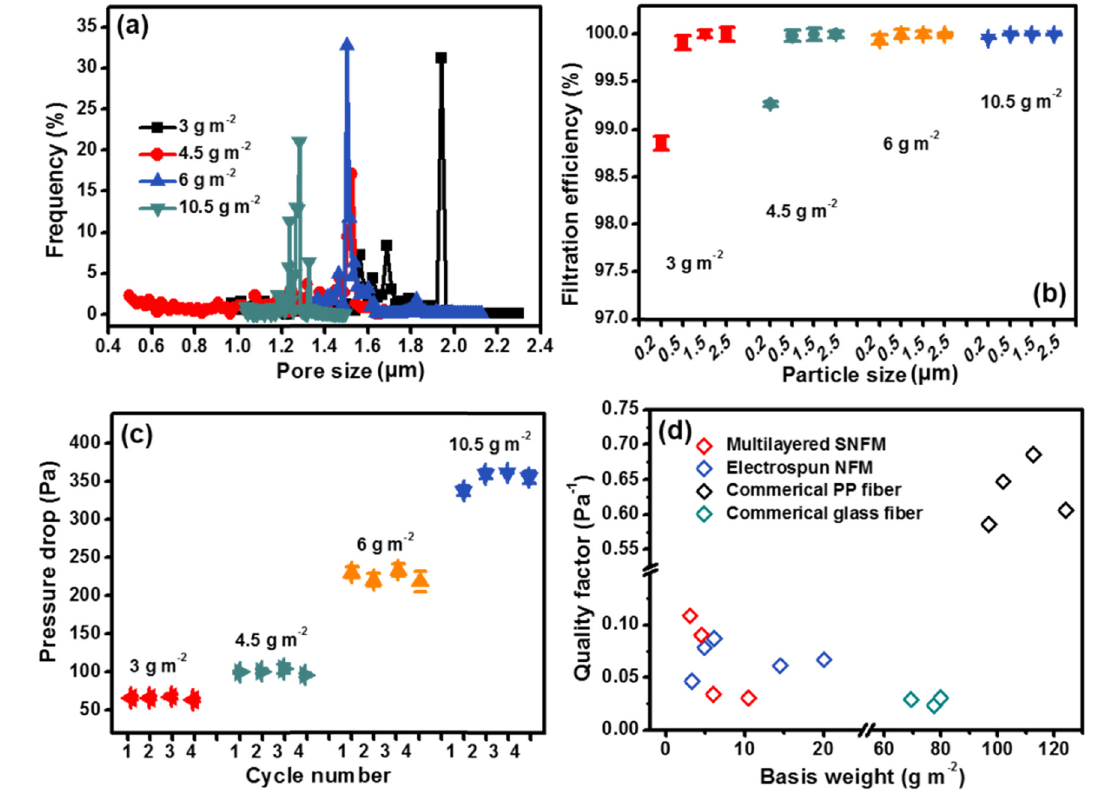
Figure 5: PSD ( a ) , fi ltration e ffi ciency ( b ) , pressure drop ( c ) , and QF values of SNFMs with various basis weights ( d )